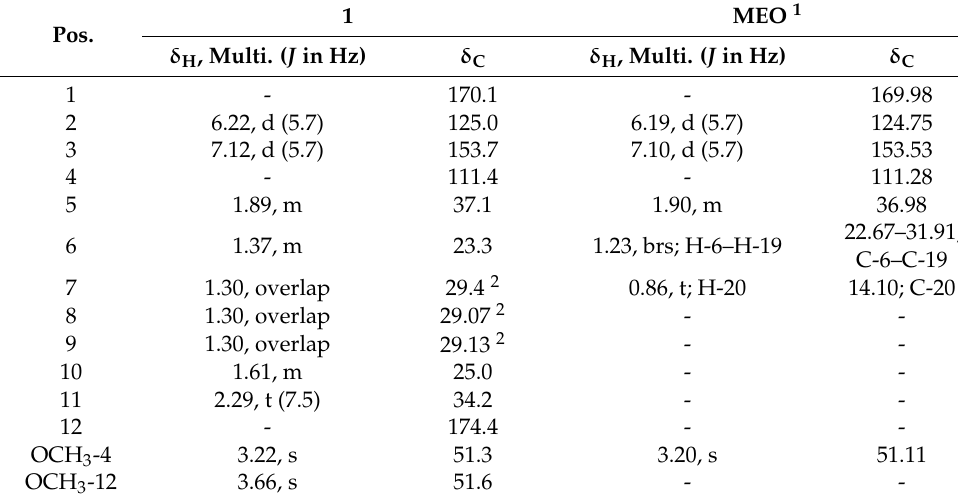
Table 2. NMR spectroscopic data of compounds 1 and MEO measured in chloroform- d . Pos.